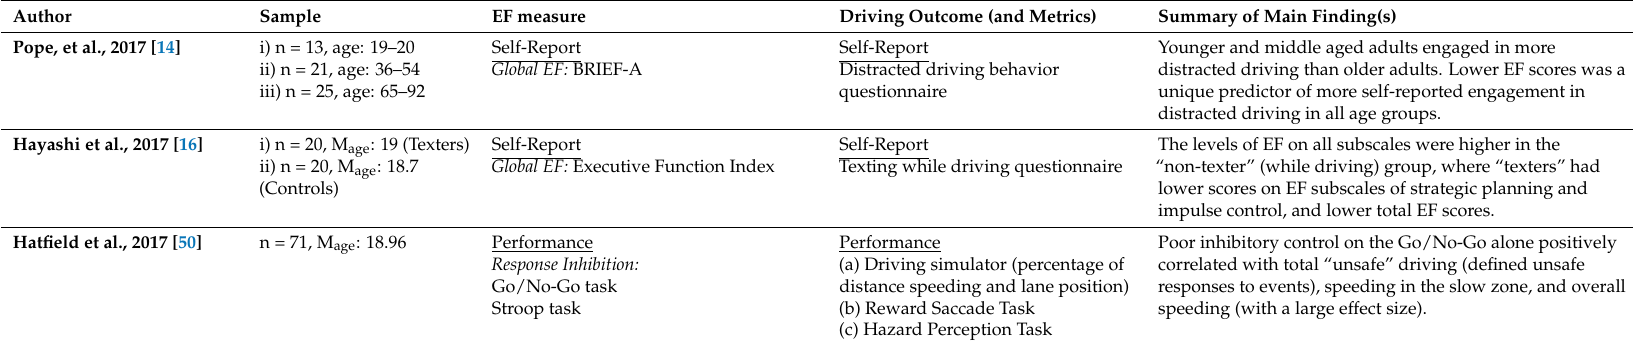
Younger and middle aged adults engaged in more distracted driving than older adults. Lower EF scores was a unique predictor of more self-reported engagement in distracted driving in all age groups. Self-Report The levels of EF on all subscales were higher in the Texting while driving questionnaire “non-texter” (while driving) group, where “texters” had lower scores on EF subscales of strategic planning and impulse control, and lower total EF scores. Poor inhibitory control on the Go/No-Go alone positively correlated with total “unsafe” driving (defined unsafe responses to events), speeding in the slow zone, and overall speeding (with a large effect